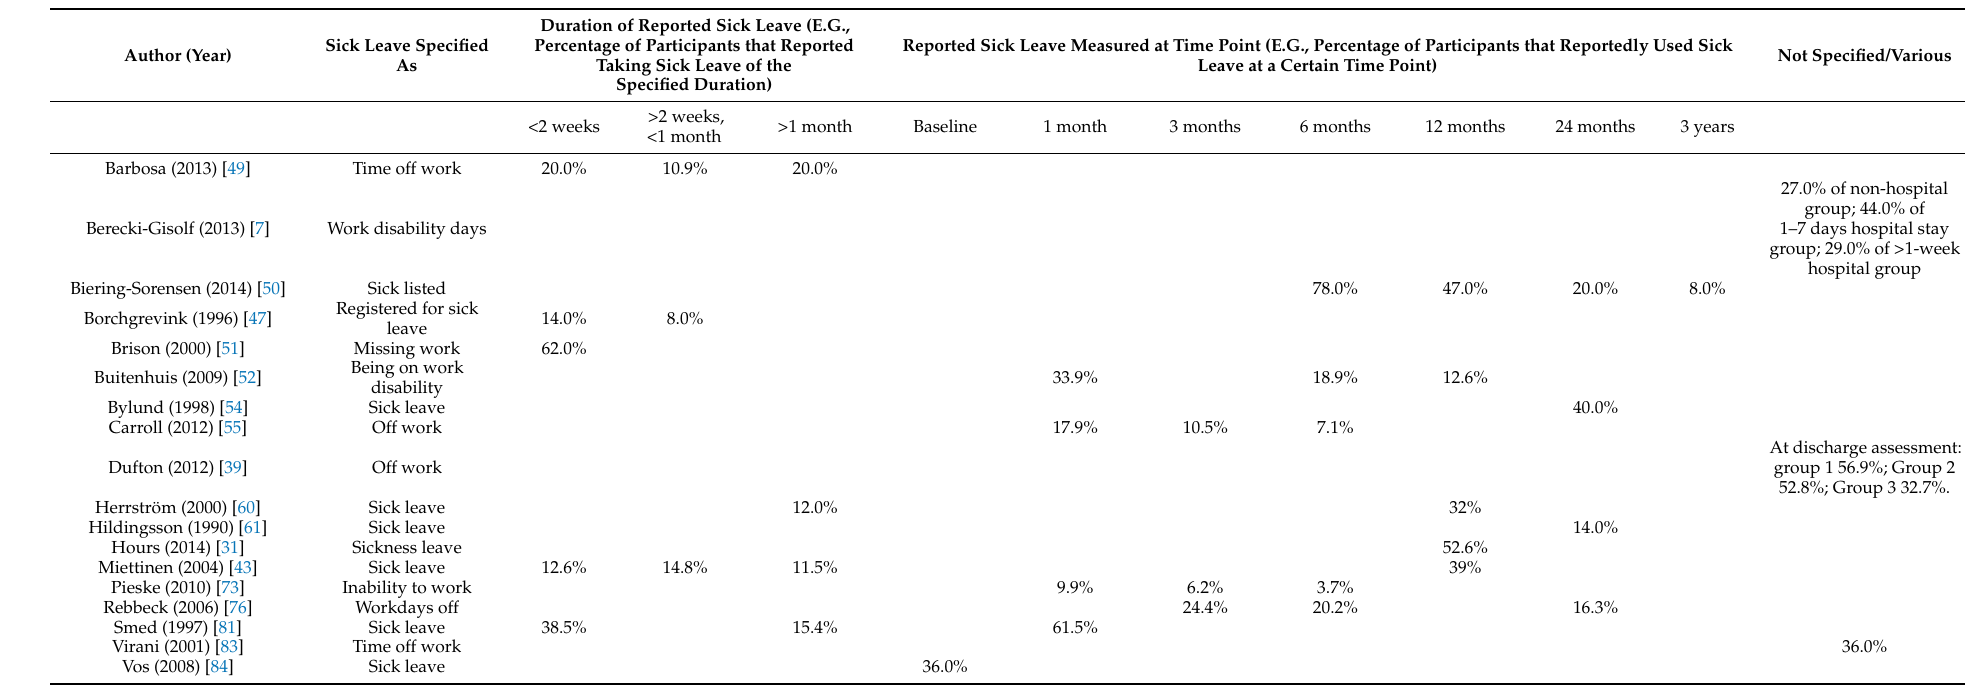
Table 4. Sick leave percentages reported as duration of sick leave or used sick leave at a certain time